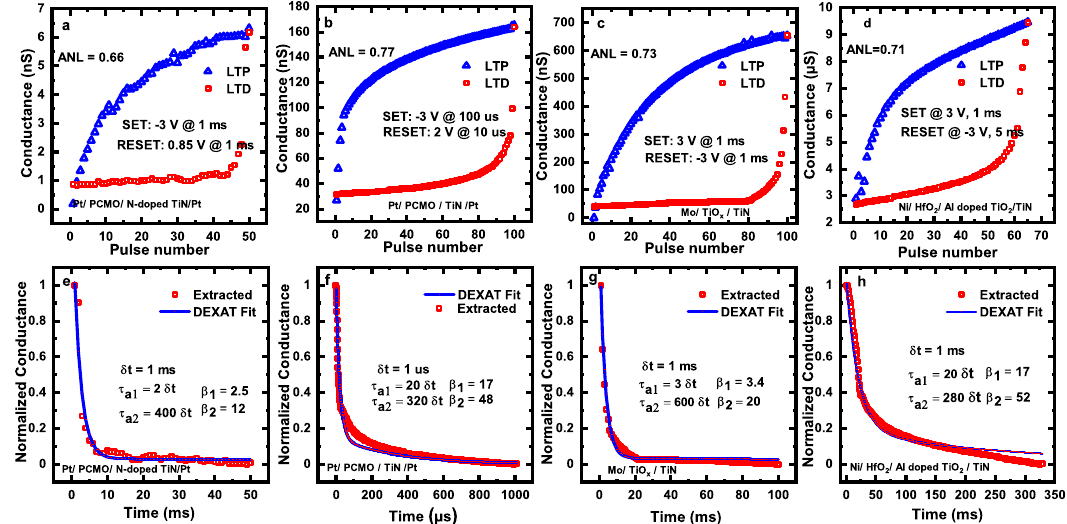
Fig. 3 DEXAT behavior extraction from non- fi lamentary OxRAM devices. a – d Extracted LTP-LTD characteristics of Pt/PCMO/N-doped TiN/Pt, Pt/PCMO/TiN/Pt, Mo/TiOx/TiN, and Ni/HfO 2 /Al-doped TiO 2 /TiN devices respectively. e – h Normalized and interpolated LTD conductance curves corresponding to ( a – d ), respectively, fi tted with DEXAT neuron equations. Extracted DEXAT neuron parameter values are indicated inside respective